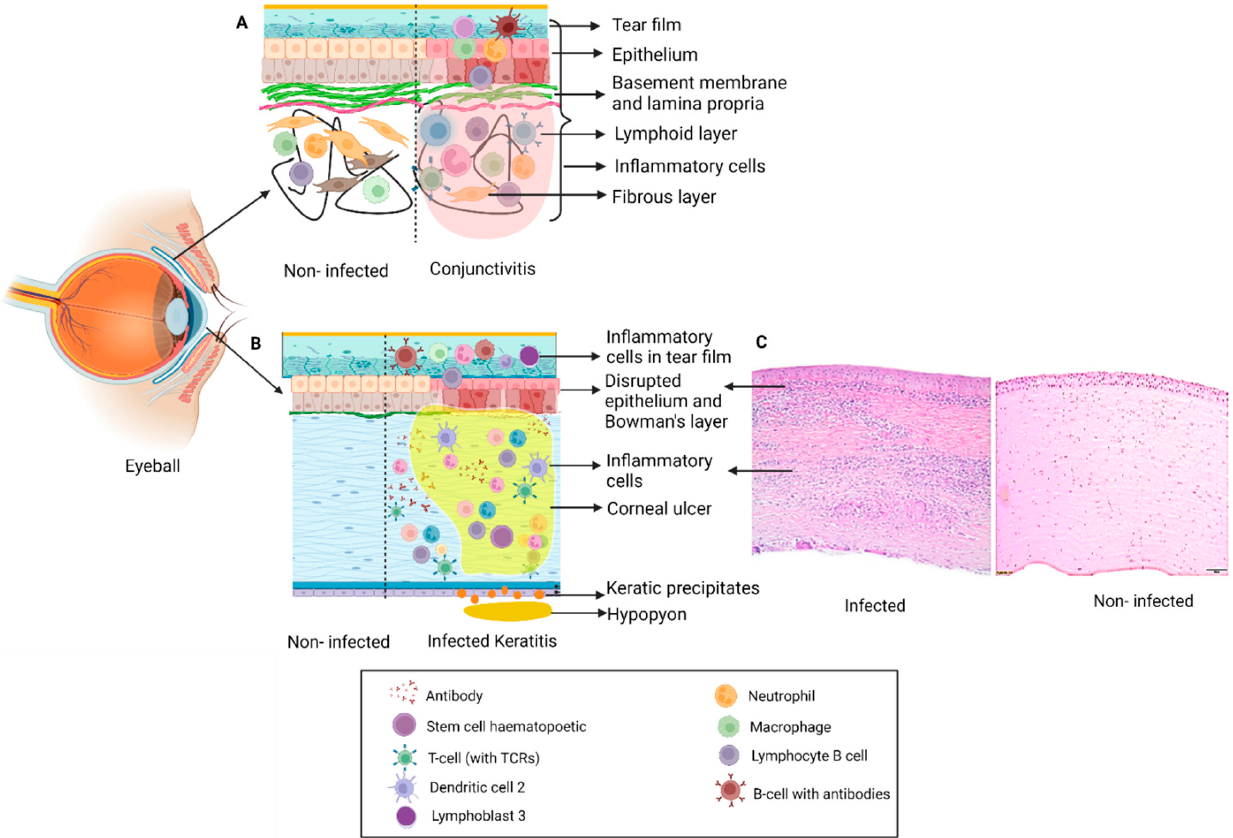
Figure 1. Schematic representation of changes in ocular tissue in: ( A ) Conjunctivitis: Inflammation of conjunctiva with infiltration of immune cells (neutrophils, lymphocytes, mast cells) which results in disruption in structure and inflammation leading to clinical symptoms and signs. ( B ) Keratitis: Infection of the cornea by different pathogens results in formation of a corneal ulcer or infiltrate with disruption in Bowman’s layer, epithelial and stromal edema with presence of inflammatory cells. Severe cases can also have inflammation in the anterior chamber in the form of hypopyon and keratic precipitates on the endothelium. ( C ) H&E staining of section on the right shows the histopathology of an infected cornea illustrating disruption of the Bowman’s layer and dense infiltration of the stroma by polymorphonuclear